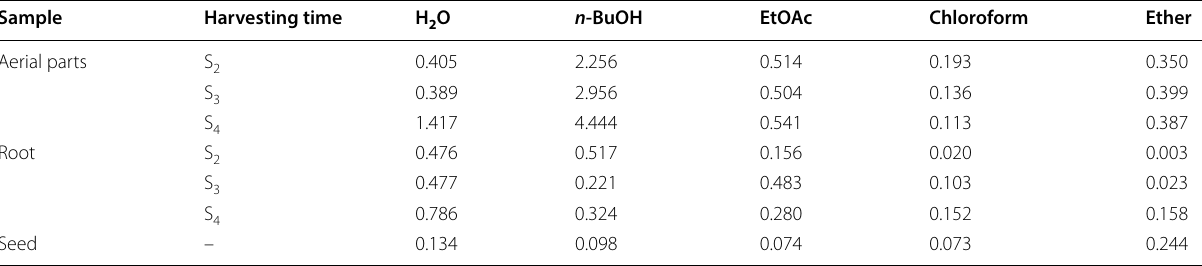
Table 4 The amounts of flavonoids compounds in the tissues extracts of the C. heratensis (mg RE/g DM a ) Sample